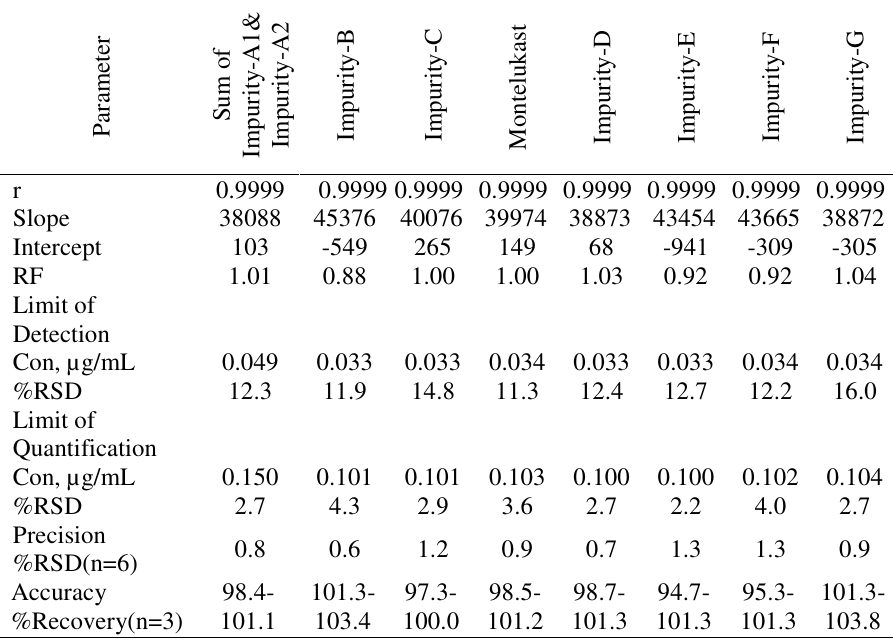
Table 2. Linearity, LOD, LOQ, precision and accuracy data for montelukast sodium and its